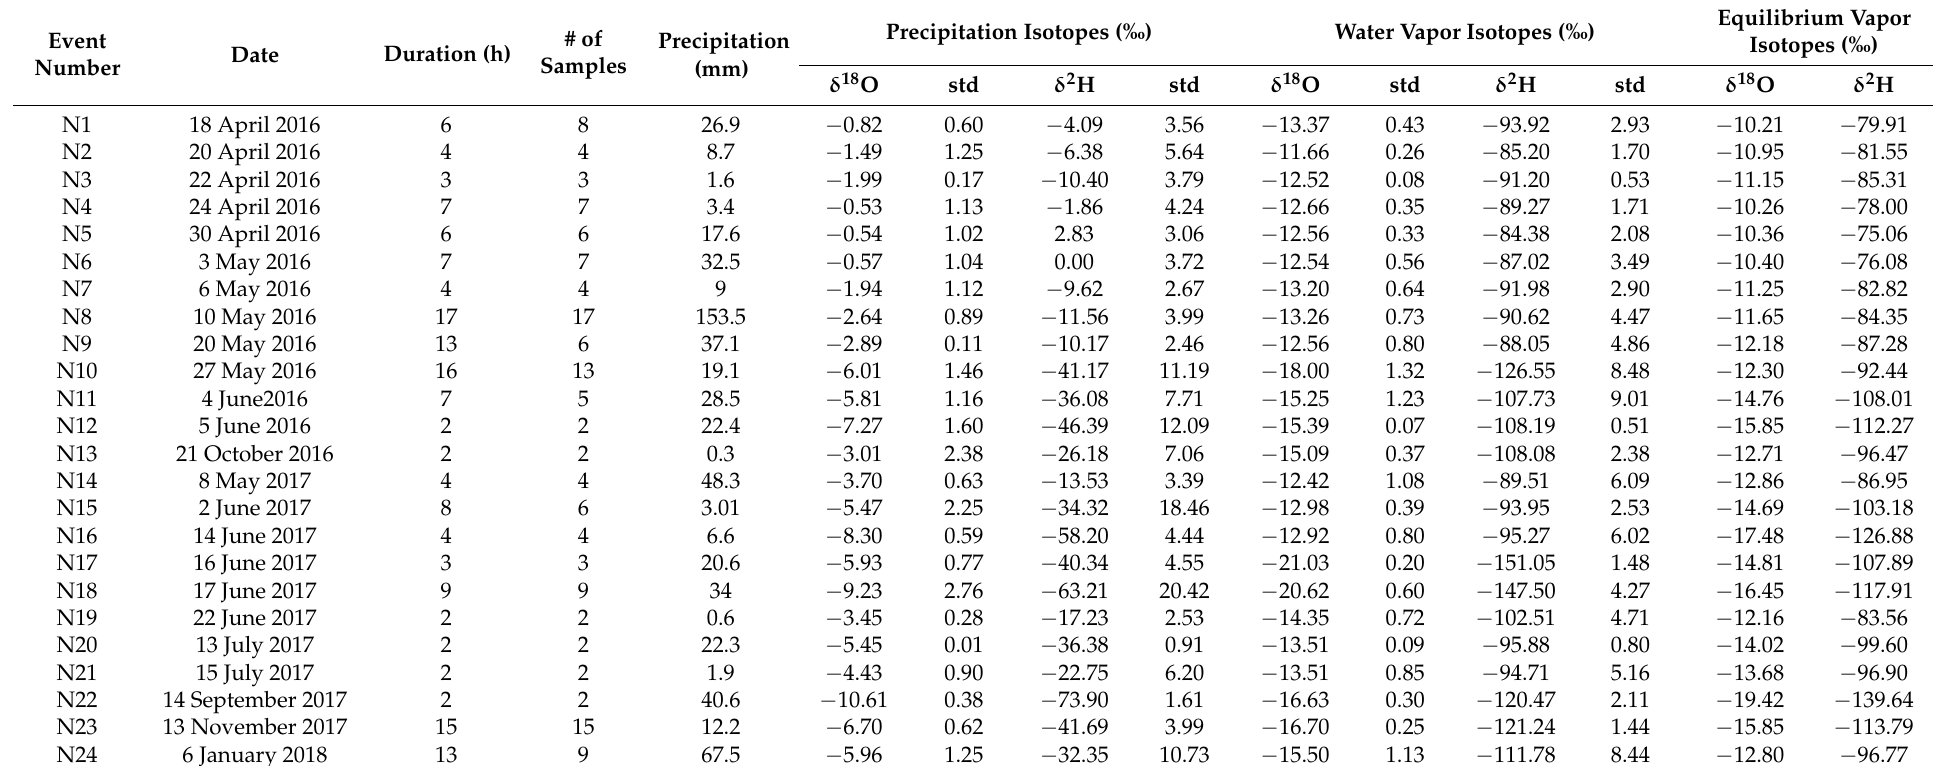
Table 1. Weighted average isotopic composition of water for each rain